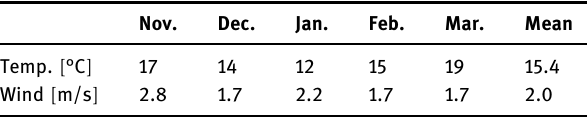
Table 3: Temperature and wind speed values during the study period